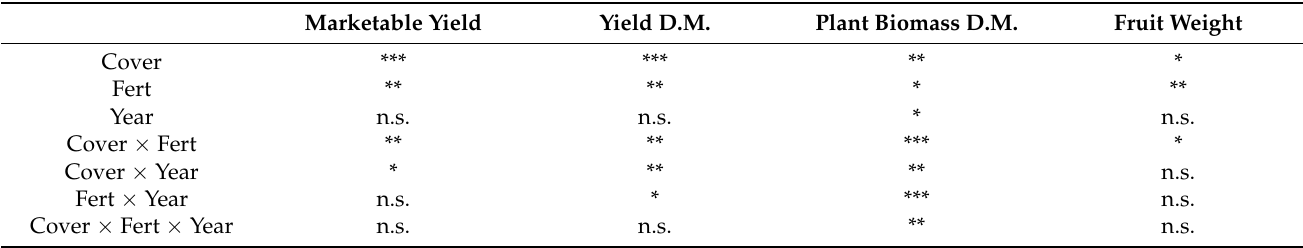
Table 3. Analysis of variance (ANOVA) of the different analyzed parameters (marketable yield, yield dry matter—d.m., fruit weight and plant biomass dry matter). Marketable Yield Yield D.M. Plant Biomass D.M. Fruit Weight